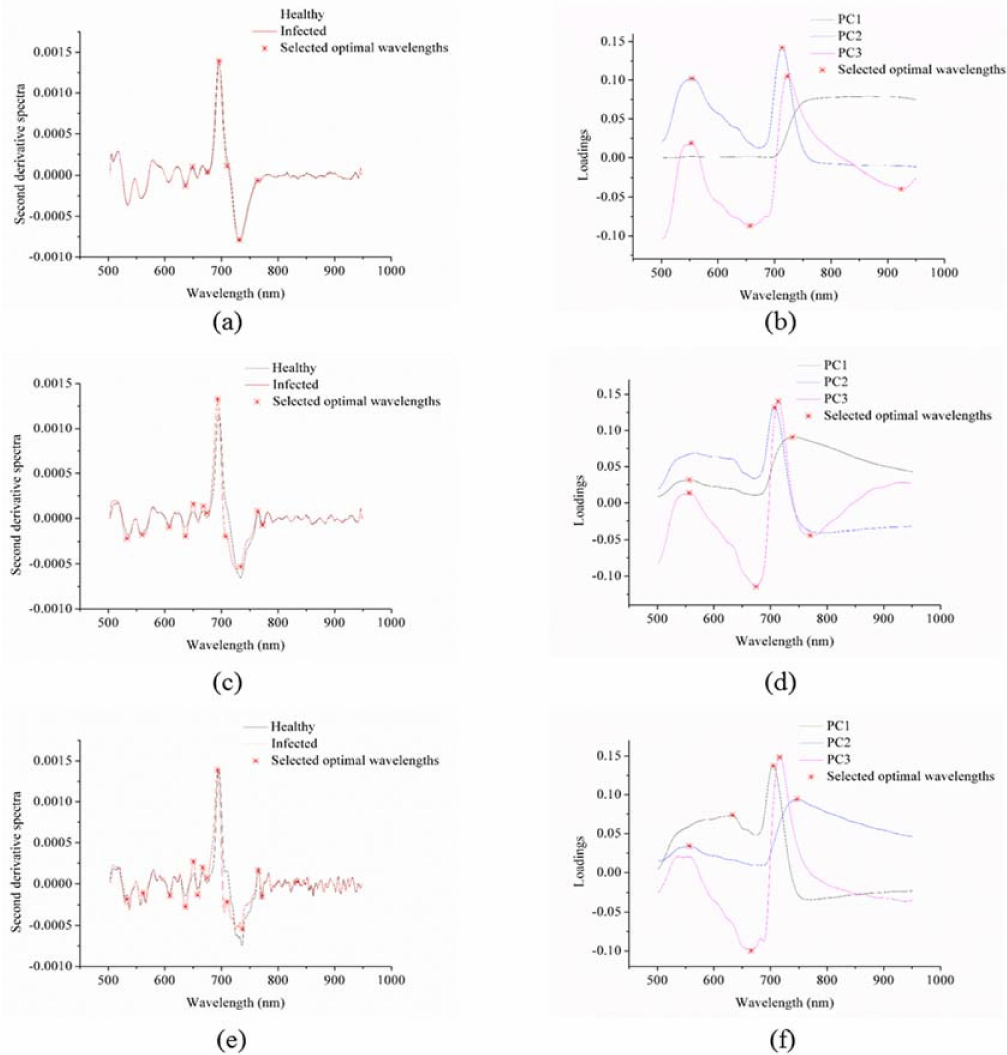
Figure 2. The optimal wavelength selection by the second derivative spectra of the sample sets 1, 2, and 3 (( a , c , e ), respectively) and the principal component analysis (PCA) loadings of the three sets (( b , d , f ),